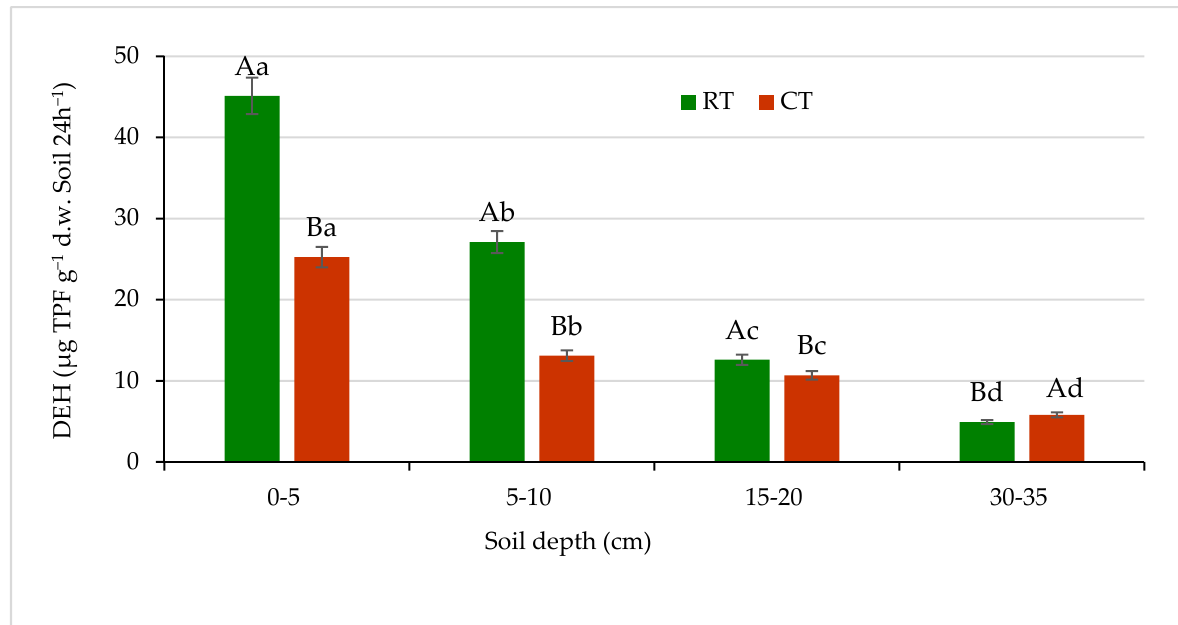
Figure 9. Dehydrogenases (DEH) activity in soil under different tillage systems in 2018–2020 (expressed as means for the 3 years, n = 12). Different letters represent significant differences ( p ≤ 0.05) across treatments according to Tukey’s HSD test; lowercase letters within the same tillage system indicate significant differences between soil depths; uppercase letters indicate differences between tillage systems. RT—reduced tillage system; CT—conventional tillage system; d.w.—dry weight of soil; n —number of samples. Vertical bars represent standard errors.